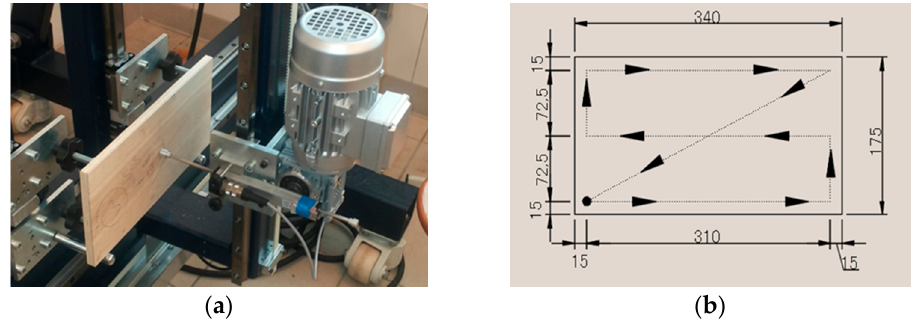
Figure 2. Flatness measurement: ( a ) CNC plotter; ( b ) Diagram of the sensor path.